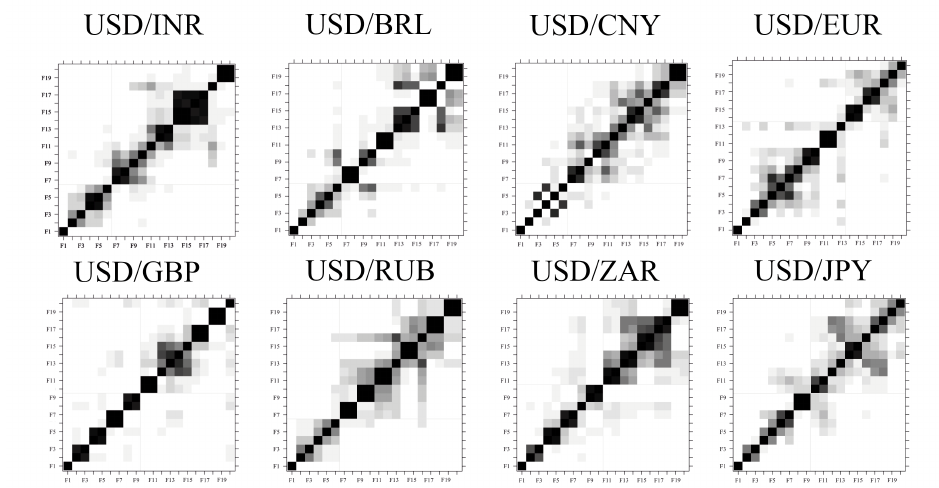
Figure A2. W-correlation matrices for each of the eight currency exchange rates, considering an window length L 2 = N /2. The vertical and horizontal lines in each w-correlations plot indicate the selected cut-point that maximize separability between signal and noise components.